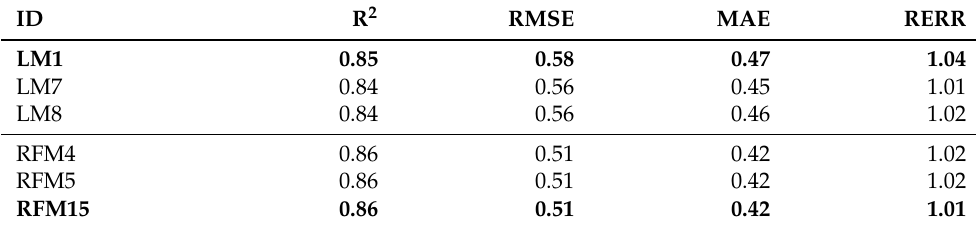
Table 2. Average values of goodness-of-fit of selected